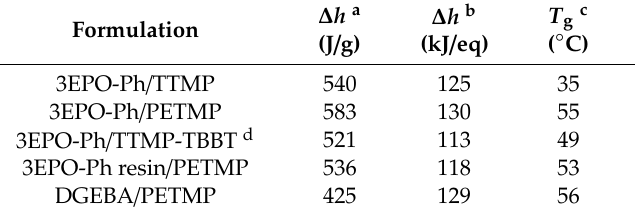
Table 2. Calorimetric data from the curing of the di ff erent formulations, catalysed by 1 phr of BG.